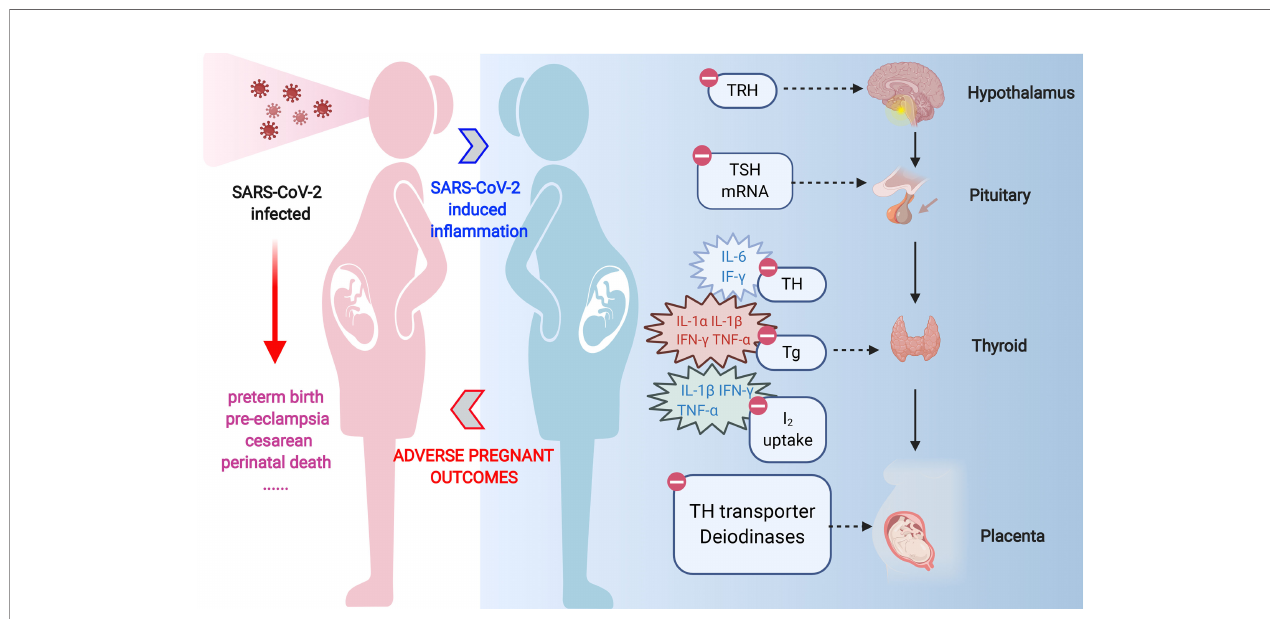
FIGURE 2 | The effects of pro-in fl ammatory cytokines on TH synthesis pathway in the thyroid. During the process of TH production and release, IL-1 a and IL-1 b inhibit the TSH-induced Tg mRNA expression and Tg release in human cultured thyrocytes. IL-1 b is also responsible for the impairment of basal and TSH-stimulated uptake of iodide by the NIS in porcine thyroid follicle. IL-6 inhibits TPO mRNA expression and T3 secretions. IFN- g inhibits TSH-induced Tg mRNA expression, Tg and TH secretion, and TSH-induced TPO expression. Besides, TSH-induced increase in NIS expression is eliminated by IFN- g in rat FTRL-5 cells. TNF- a is known to downregulate Tg production and release in cultured thyrocytes. TNF- a also inhibits NIS expression in rat FTRL-5 cells. TH, thyroid hormone; Tg, thyroglobulin; NIS, natrium/iodide symporter; TPO,